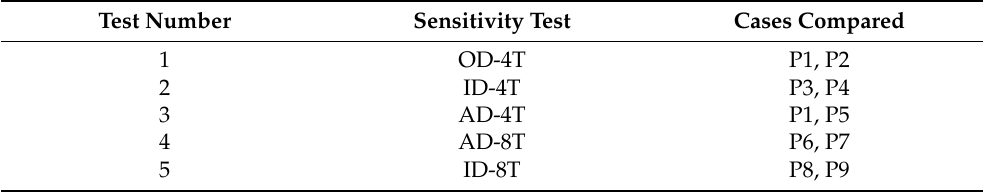
Table 5. Sensitivity tests to evaluate the effects of the parameters AD, ID, and OD in the simulations. Test Number